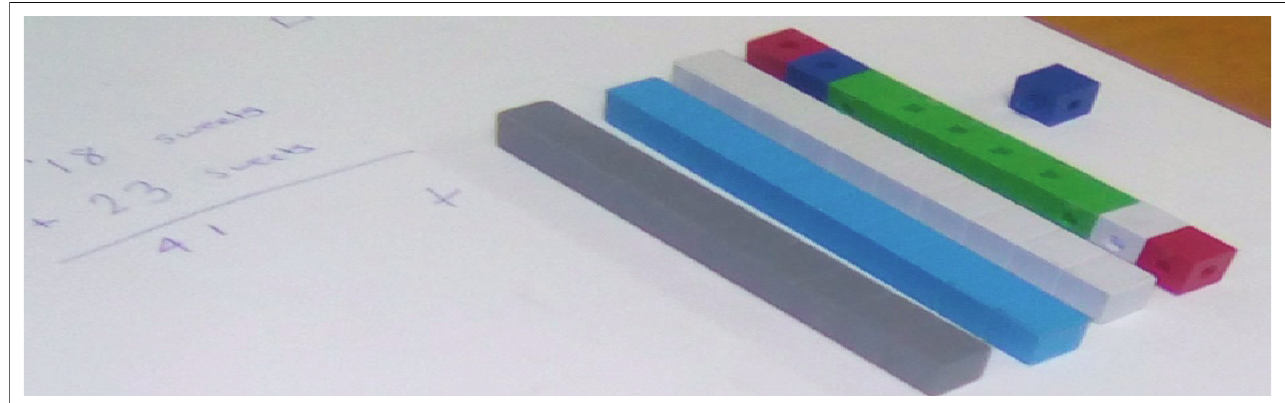
FIGURE 5: Sample of students’ written responses to item